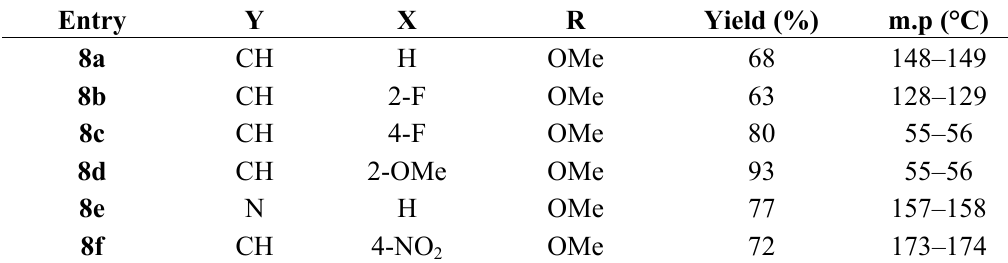
Table 2. Yields of the reduced derivatives 8a–f .